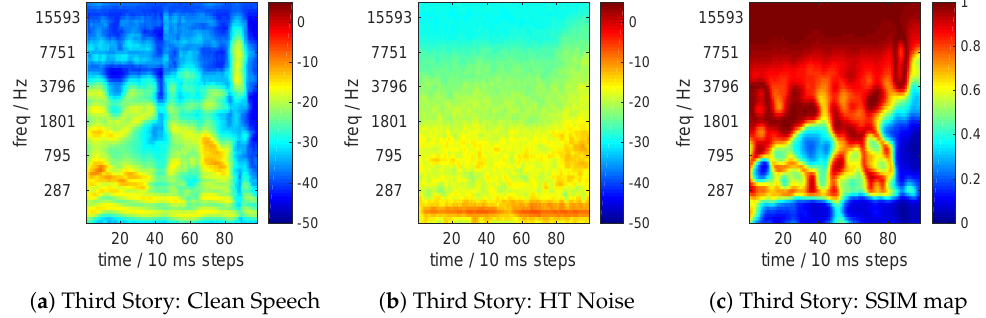
Figure 7. ( a ) The gammatonegram of one of the words uttered (and presented to the subjects in the experiments for the word spotting task) from the third story without any masker; ( b ) the gammatonegram of the masker (heavy traffic) sound frame overlapping the word in ( a ); and ( c ) the SSIM map between the two gammatonegrams in ( a , b ). The SSIM index is 0.69.